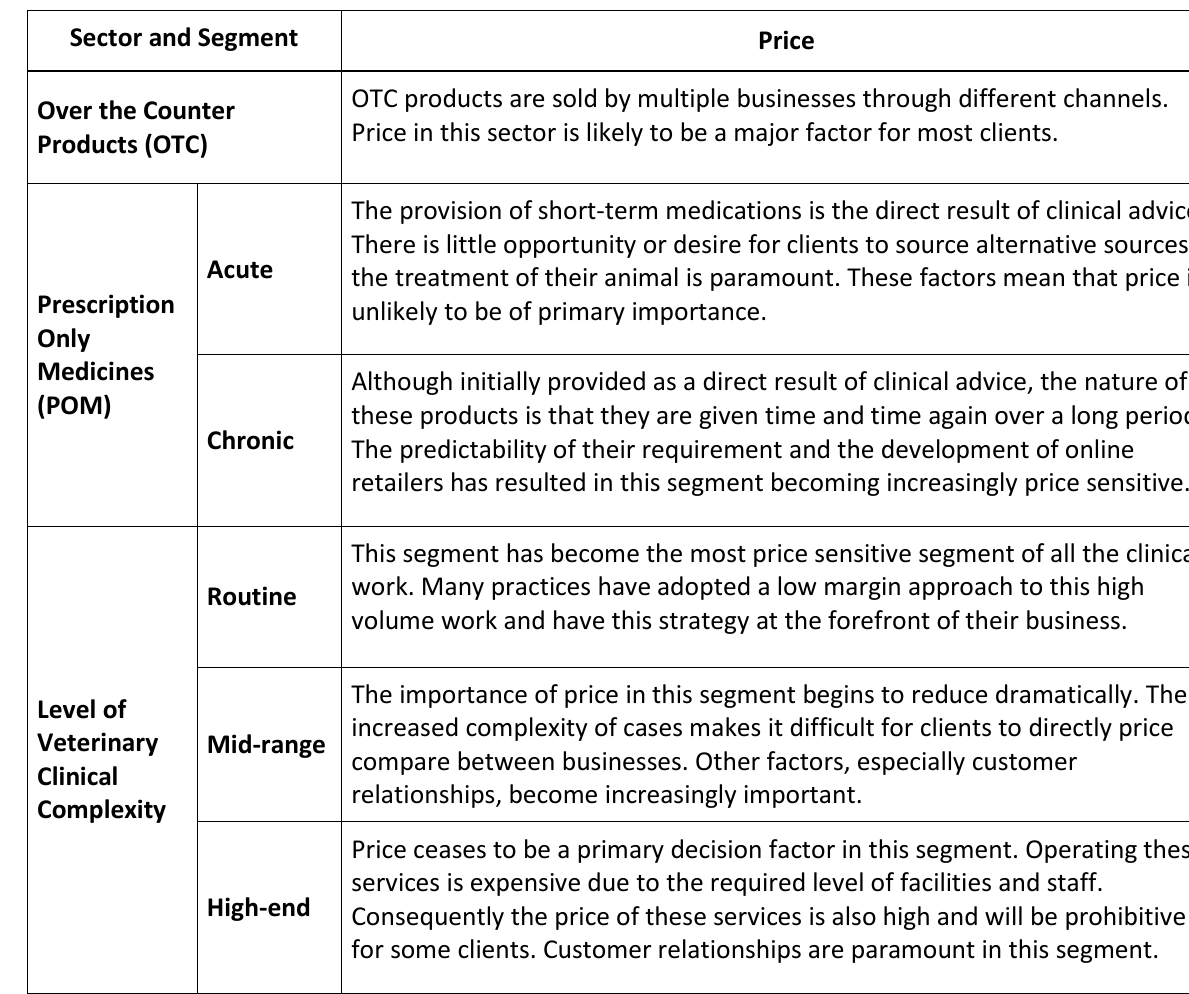
Figure 5. The varying importance of price in small animal market segments The identification of how each market segment impacts practice revenue and the associated importance of the relevant choice criteria forms a fundamental understanding of a business. Once this base is established a business can then decide how it should progress given both its internal capabilities and the external competition it faces. Choosing the markets in which to compete is a business based decision that sits at the heart of both current and future strategy development. It is not a singular process as it influences and is influenced by all relevant functions that comprise a veterinary practice (see Figure